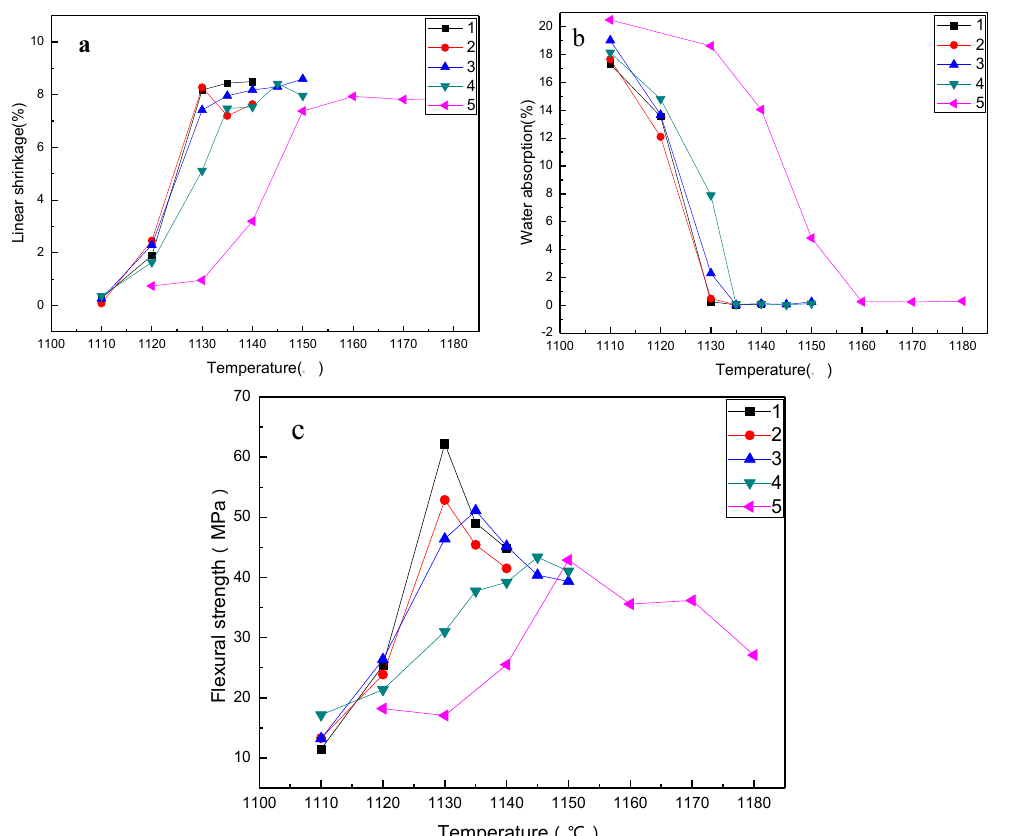
Figure 2. Variation in shrinkage, water absorption, and flexural strength at different sintering temperatures: ( a ) shrinkage versus sintering temperature; ( b ) water absorption versus sintering temperature; ( c ) flexural strength versus sintering temperature. Table 3. Optimum sintering temperature and physical properties at the optimum sintering temperature.